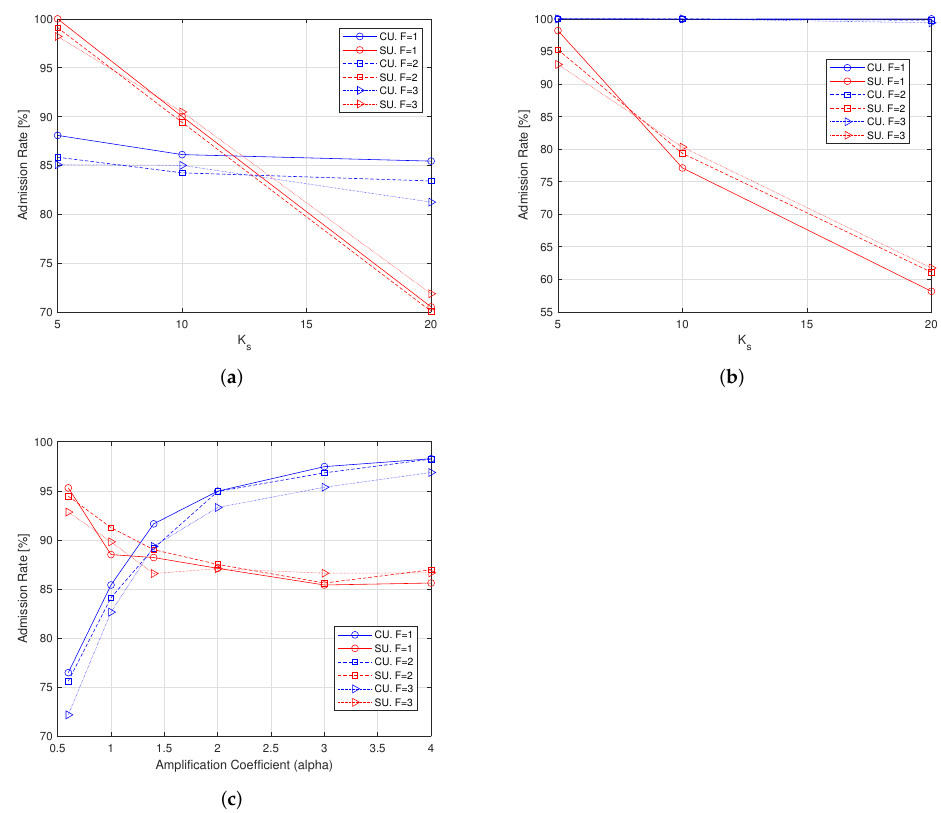
Figure 4. Admission rate with K c = 30 users, different values of F and K s , 100 iterations. ( a ) Varying K s , α = 1, CE-aware; ( b ) varying K s , α = 1, CE-unaware; ( c ) varying α , K s = 10,